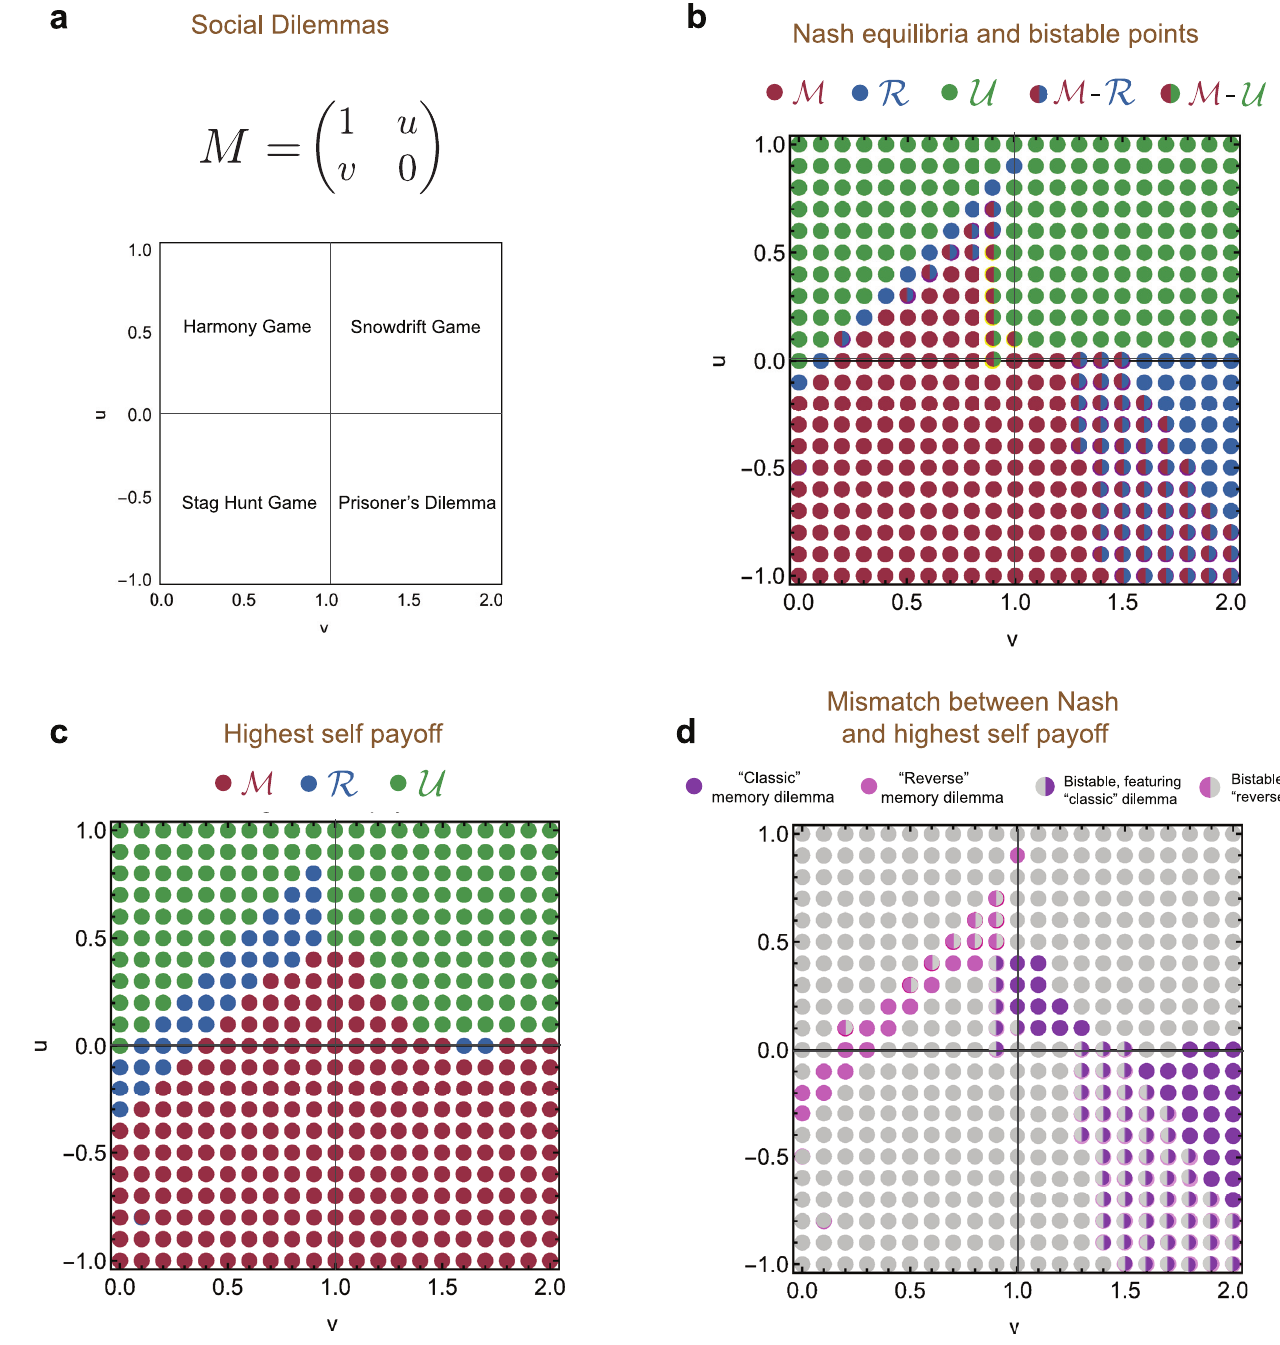
Fig 5. Evolutionary dynamics of memory spaces for different game structures. We explore whether memory dilemmas are present in games beyond the repeated Prisoner’s Dilemma by repeating our previous simulations for various game matrices. a , We consider matrices parametrized by v and u . The parameter v varies in the interval [0, 2], and the parameter u varies in [ − 1, 1]. We can partition the resulting two dimensional space of game matrices into four quadrants. The lower right quadrant contains games with a Prisoner’s Dilemma (PD) structure like the donation game, whereas the other quadrants contain the other fundamental social dilemmas Snowdrift (SG), Harmony (HG), and Stag Hunt (SH) games. For each of these games, we do the same kind of analysis as for the donation games studied earlier. b , First, we depict the Nash equilibria of the 3 × 3 payoff matrices when the spaces M , R and U compete. For each strategy space, we find parameter regions where this space is an equilibrium. Additionally, we identify regions in which more than one space is stable. c , Here, we show the strategy space with the highest self- payoff. Memory-1 strategies tend to get the highest self-payoff in the PD and SH. In the other two game classes, strategy spaces of lower complexity can be more effective. d , We distinguish two kinds of memory dilemma. In the “classic” one, the strategy space with highest complexity gives the highest self-payoff, but is not a Nash equilibrium. In the “reverse” one, it is a less complex strategy space that yields the higher self-payoff without being an equilibrium. Both dilemmas also appear in their “weak” forms when bistabilities occur. Parameters: β = 100, simulations run for T = 10 9 .